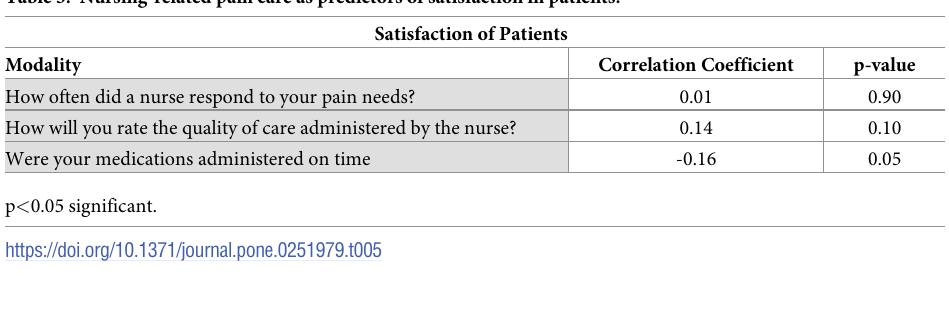
Table 5. Nursing-related pain care as predictors of satisfaction in